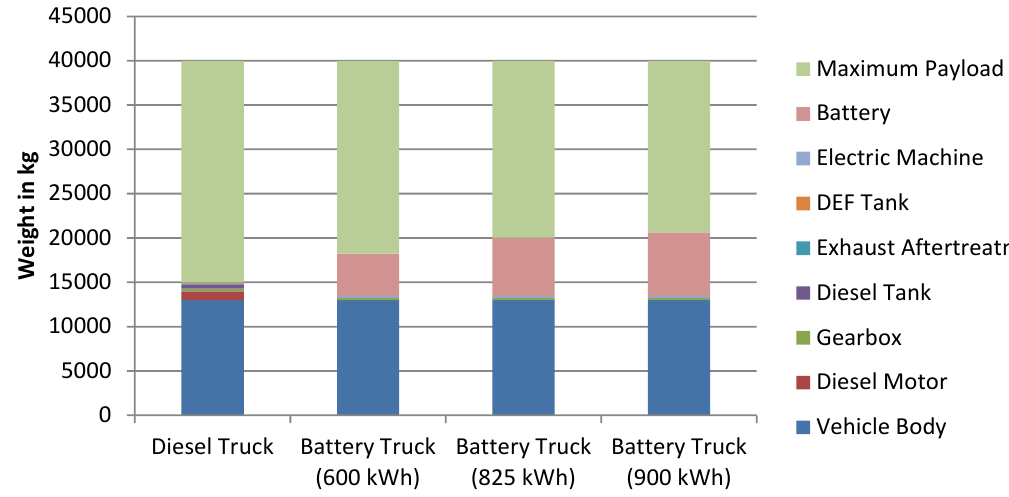
Figure 13. Weight breakdown of main truck components for the diesel trucks and battery electric trucks with different traction batteries.